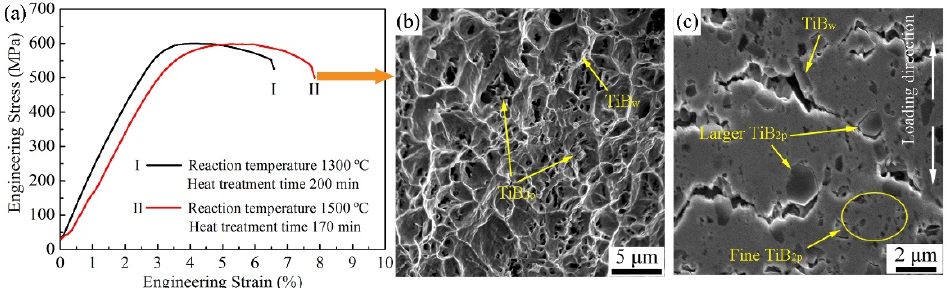
Figure 8. ( a ) Stress–strain curves of (TiB 2p +TiB w )/Cu composites with optimized preparation process, ( b ) the fracture morphology, ( c ) fracture morphology on the side of the tensile specimen. Table 3. Properties of (TiB 2p +TiB w )/Cu composites with different optimized preparation processes. Preparation Process